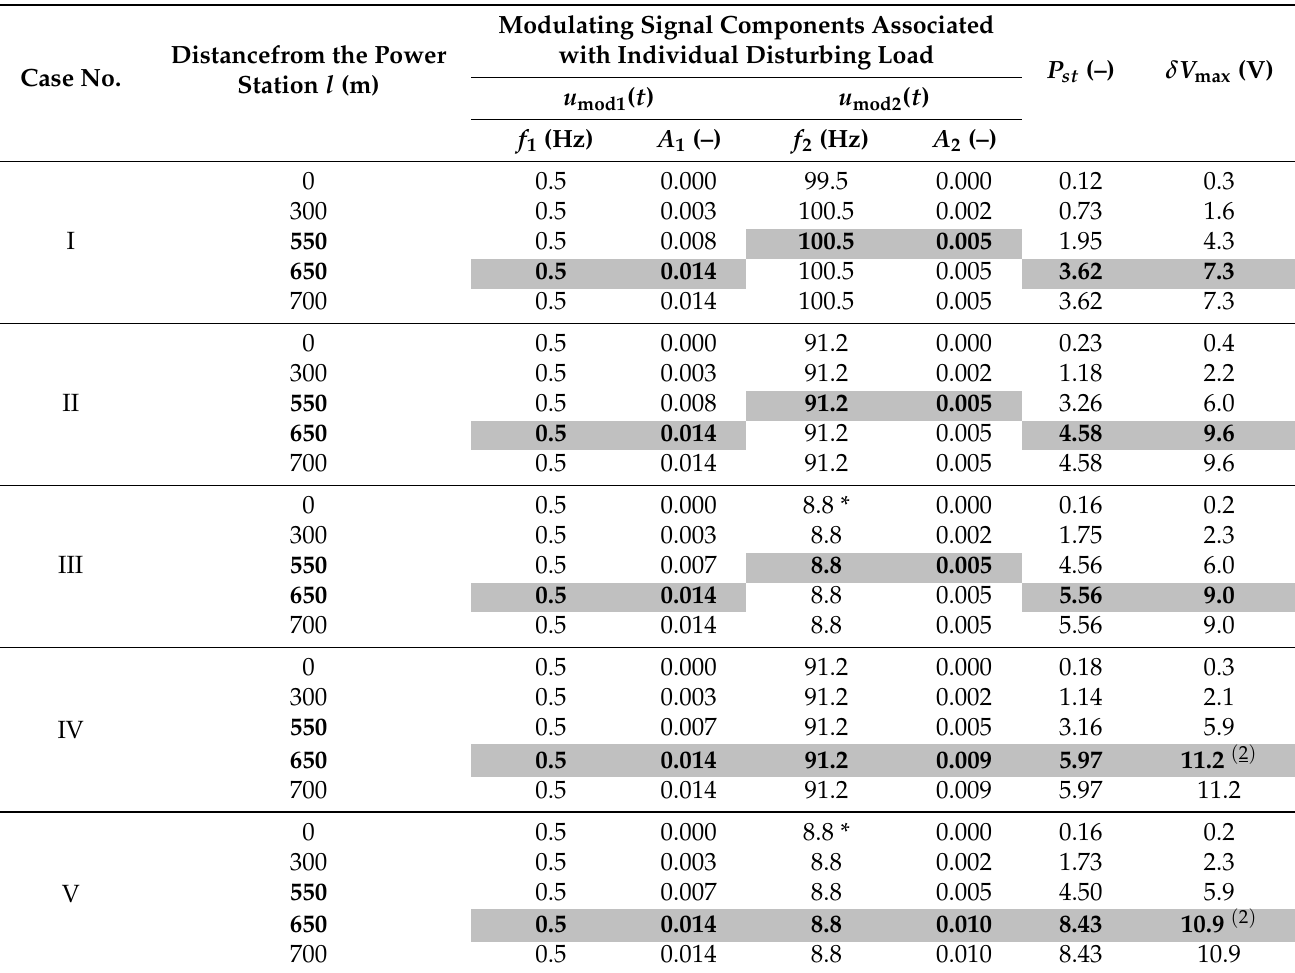
Table 6. The numerical simulation research results for Line 1.